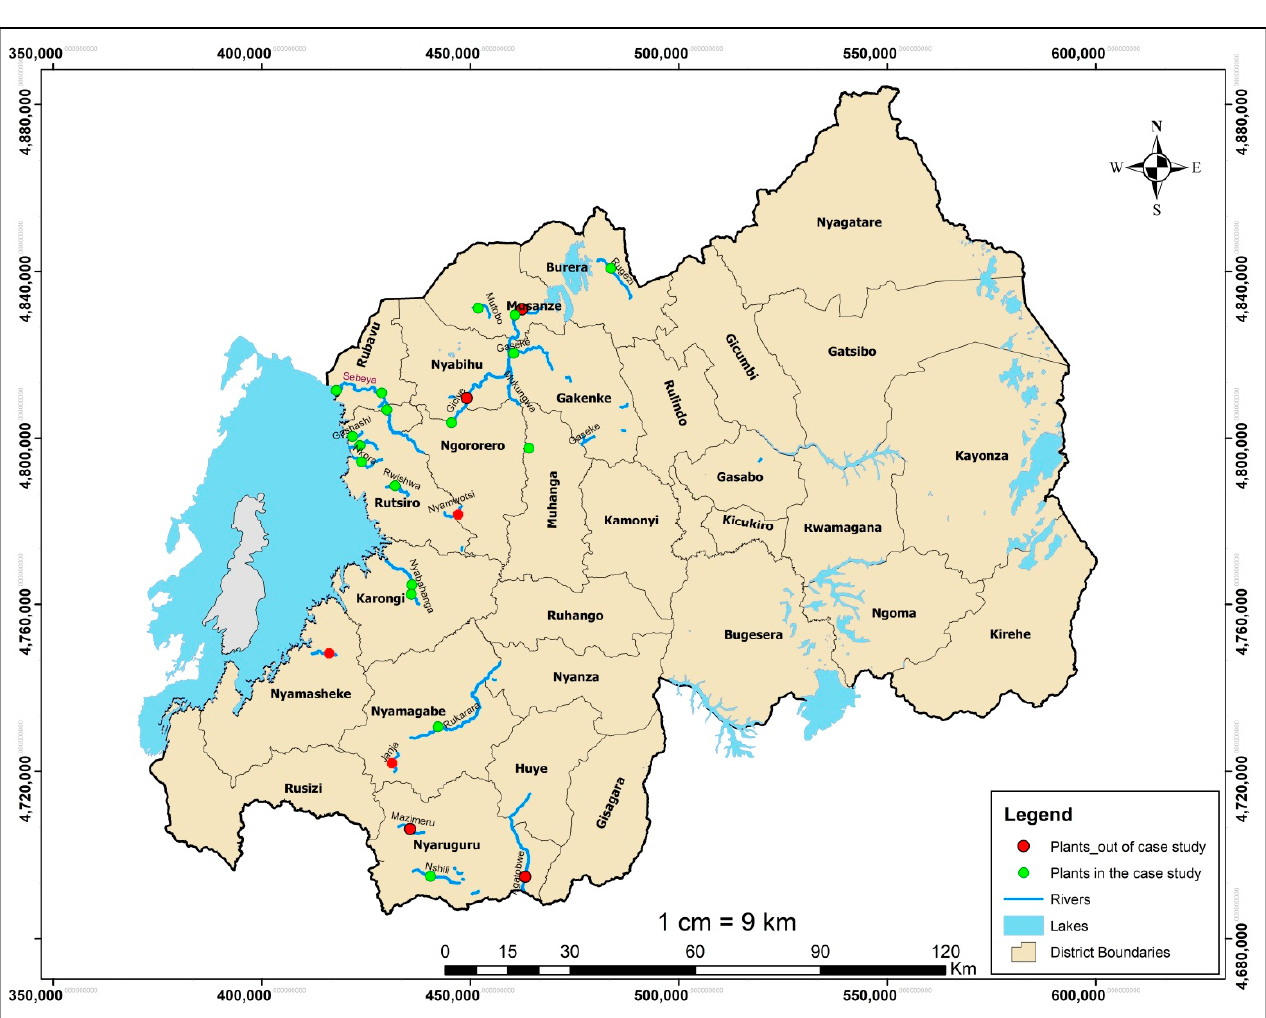
Figure 1. Map showing deployed small-scale hydropower plants included in the sample study and plants not included in the study.